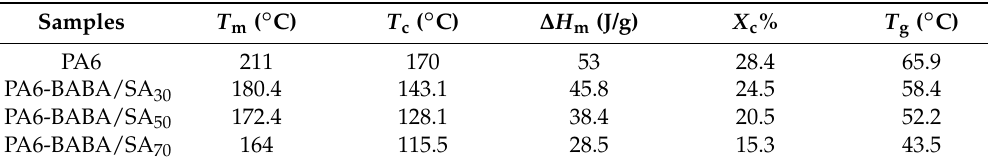
Figure 4. Differential scanning calorimetry (DSC) analyses of virgin PA6 and PA6-BABA/SA copolyamides: ( a ) heating curves (10 °C/min) and ( b ) cooling curves (10 °C/min). Table 2. Thermal properties and calculated degrees of crystallization of neat PA6 and PA6-BABA/SA copolyamides.